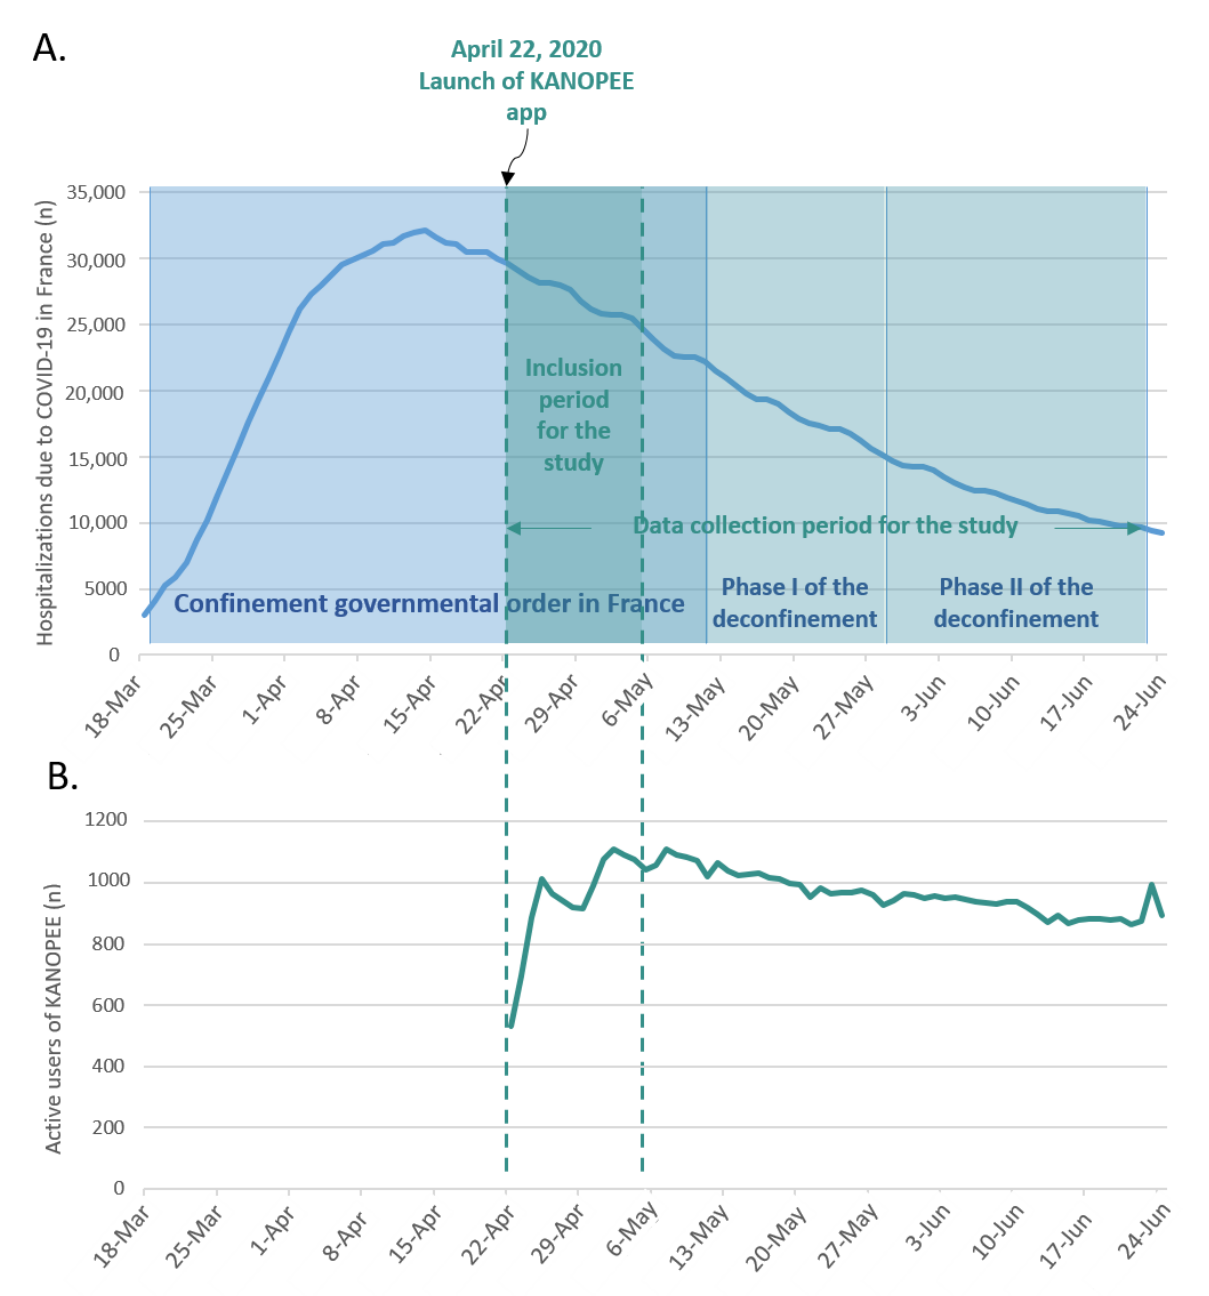
Figure 1. Conception and use of KANOPEE app. Chronological evolution of (A) the number of hospitalizations due to COVID-19 in France [20] and (B) the number of active users after the launch of the app across the confinement and deconfinement stages in France (based on data sourced from the Statistics page of the Google Play Store developer console for the